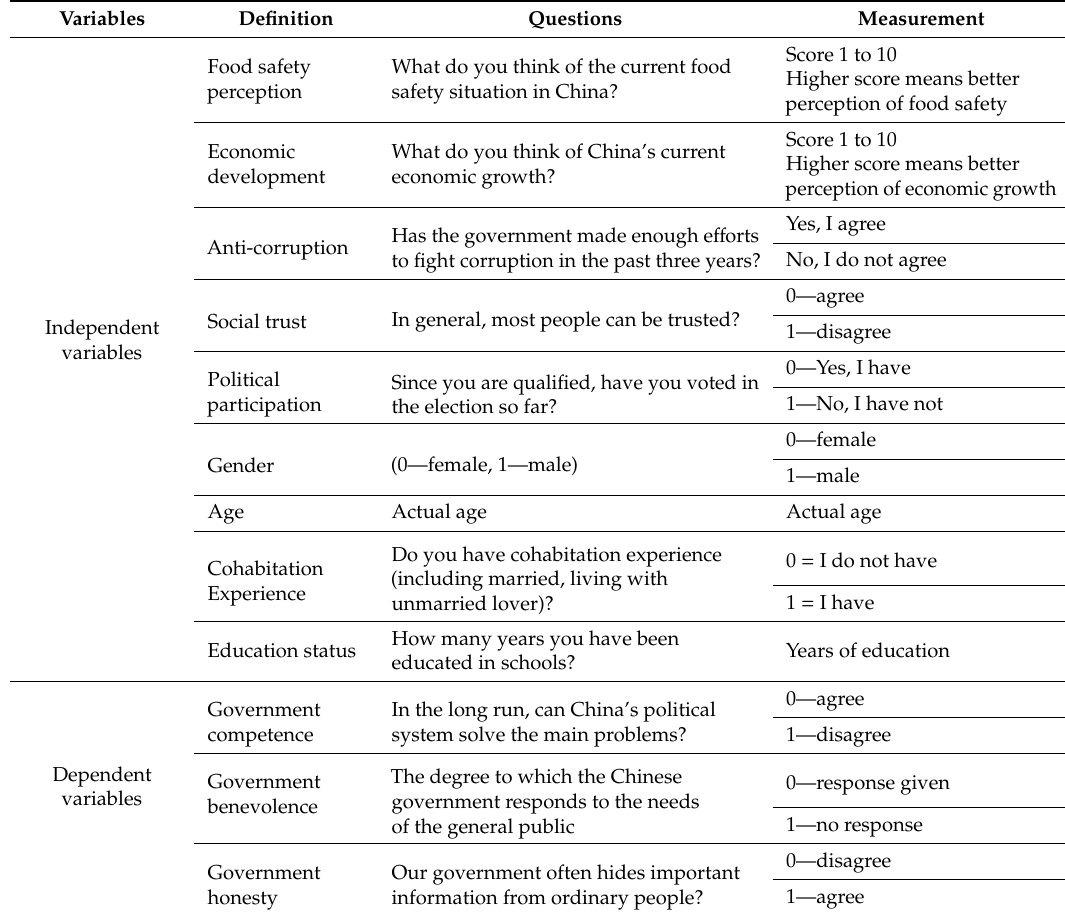
Table A1. Variables and